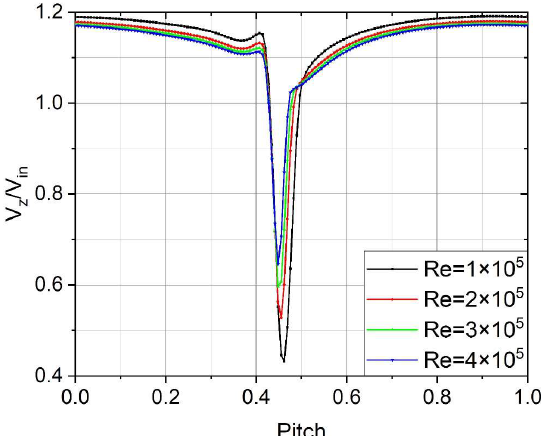
Figure 10. Circumferential distribution of inlet normalized axial velocity at 50% span.